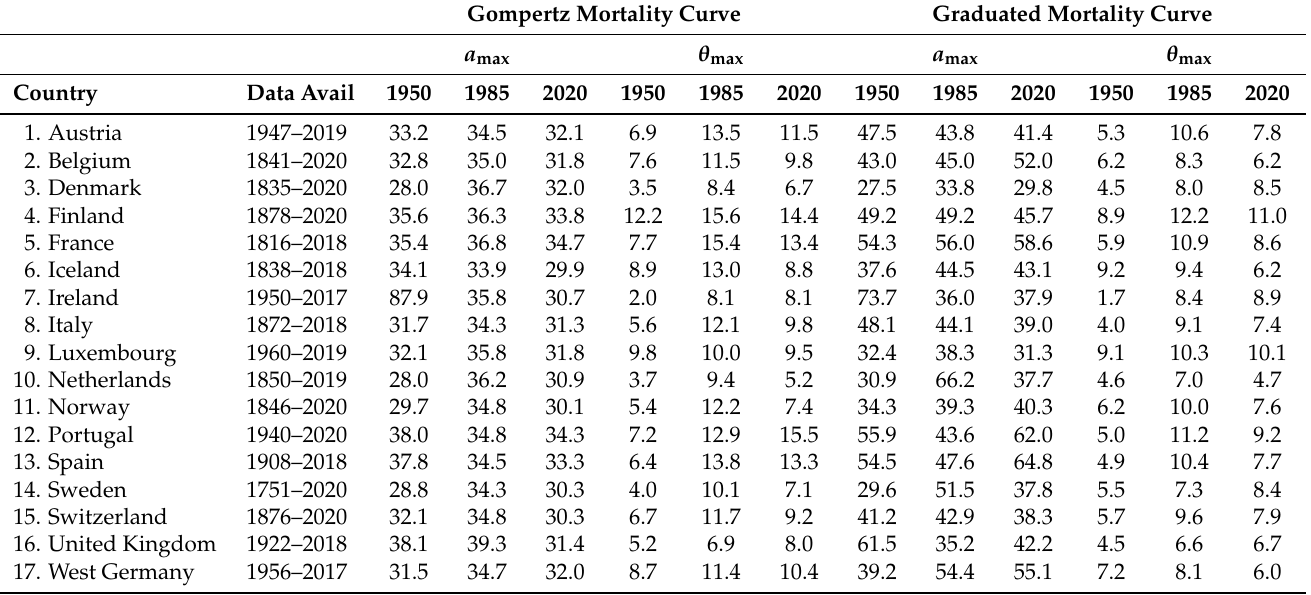
Table 1. Female life expectancy ( a max ) when the implied sex gap trajectory is at its maximum ( θ max ). For each country and model, the year refers to the data used to compute the implied sex gap trajectory, see main text for details. Life expectancies are truncated at the age of